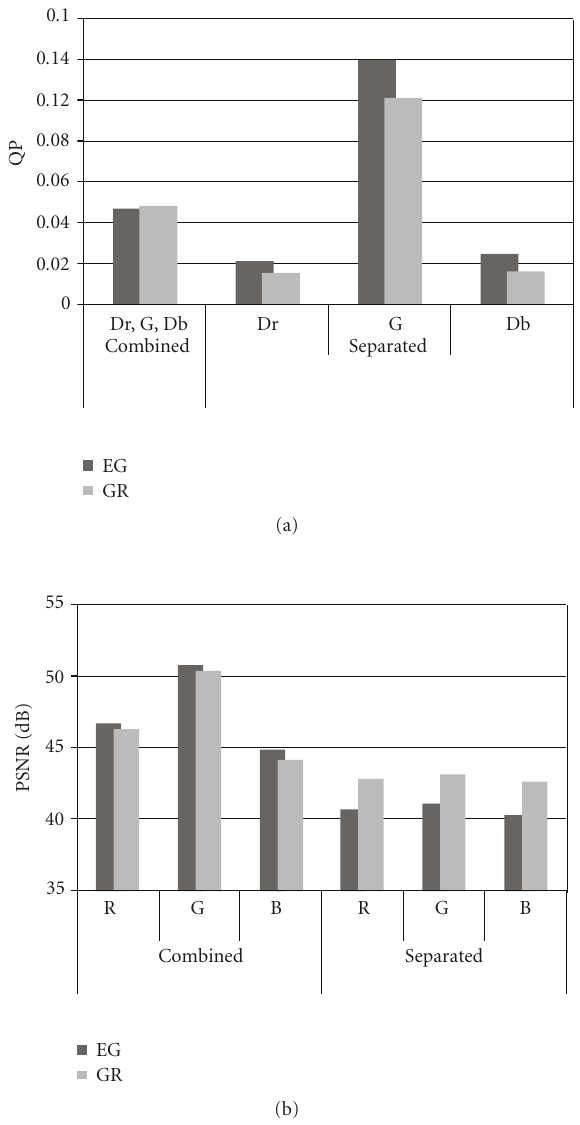
Figure 20: QP and PSNR comparison between combined and separate packetization. (a) The QP averaged over twenty-three test images shown in Figure 18. (b) The PSNR averaged over twenty- three test images shown in Figure